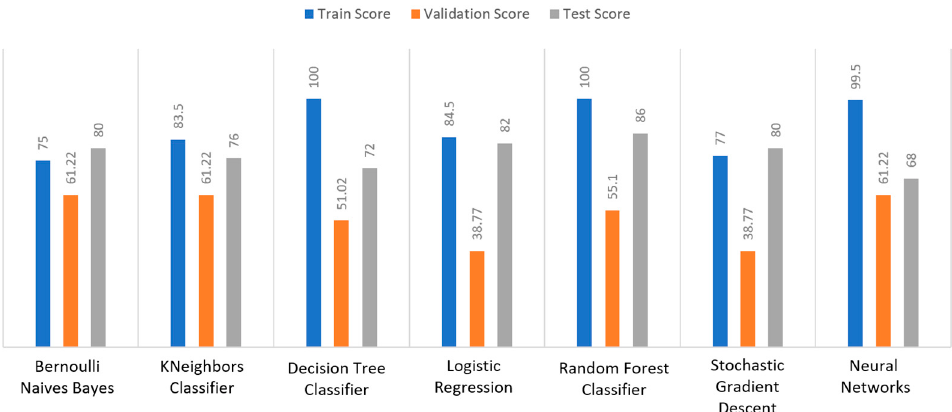
Figure 21. Train–validation–test score for heart failure use case.